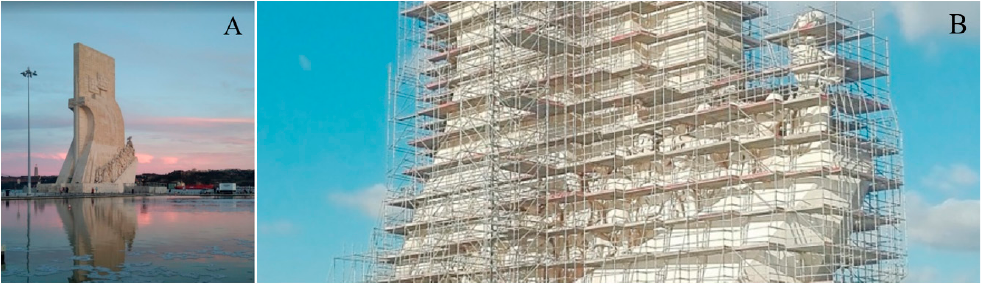
Figure 2. Photographs of the case of study: ( A ) Padrão dos Descobrimentos in 2021 and ( B ) Padrão dos Descobrimentos in 2016 (retrofitting). Sources: Images by authors and STAP.